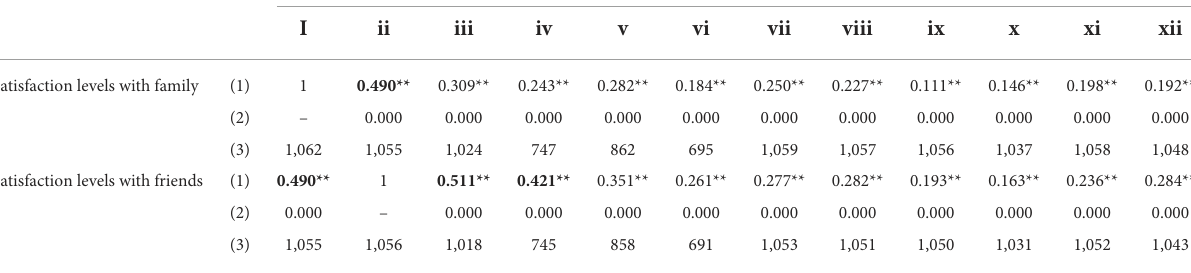
Satisfaction levels